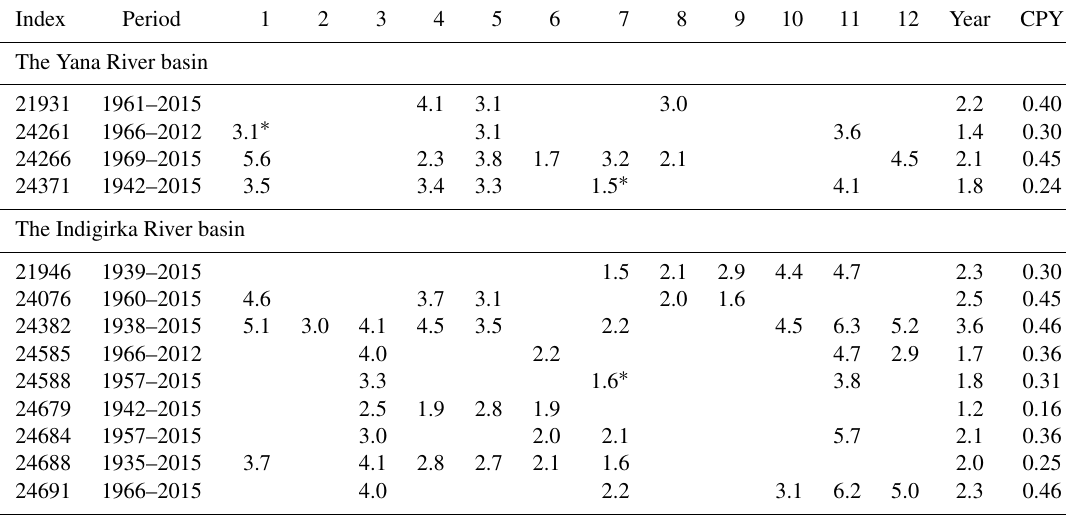
Table 3. Changes in monthly and annual air temperature ( ◦